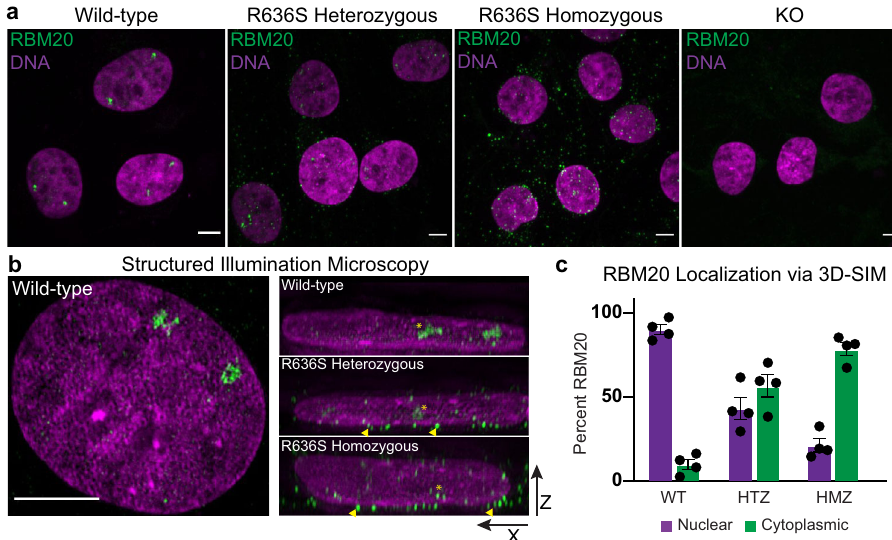
Fig. 2 Intracellular RBM20 localization in RBM20 Mutant iPSC-CMs. a Immuno fl uorescence for RBM20 in WT and RBM20 mutant iPSC-CMs. Spinning disk confocal, scale bar: 5 μ m. Representative micrographs from n > 3 experiments. b Structured illumination microscopy of DNA (magenta) and RBM20 (green). Left WT image represents X – Y maximum intensity projection, right images represent X – Z 3D projections. Yellow arrowheads indicate perinuclear localization of RBM20 in mutant cells. Yellow stars indicate the nuclear localization of RBM20. Scale bar: 5 μ m. Representative micrographs from n > 3 experiments. c 3D localization analysis of RBM20 from 3D-SIM images. Magenta bars (left bar above genotype) indicate percent nuclear localization, green bars (right bar above genotype) indicate percent cytoplasmic localization. Data represents per-cell averages from N = 2 independent experiments with n = 4 cells per genotype. Data represented as mean values ±